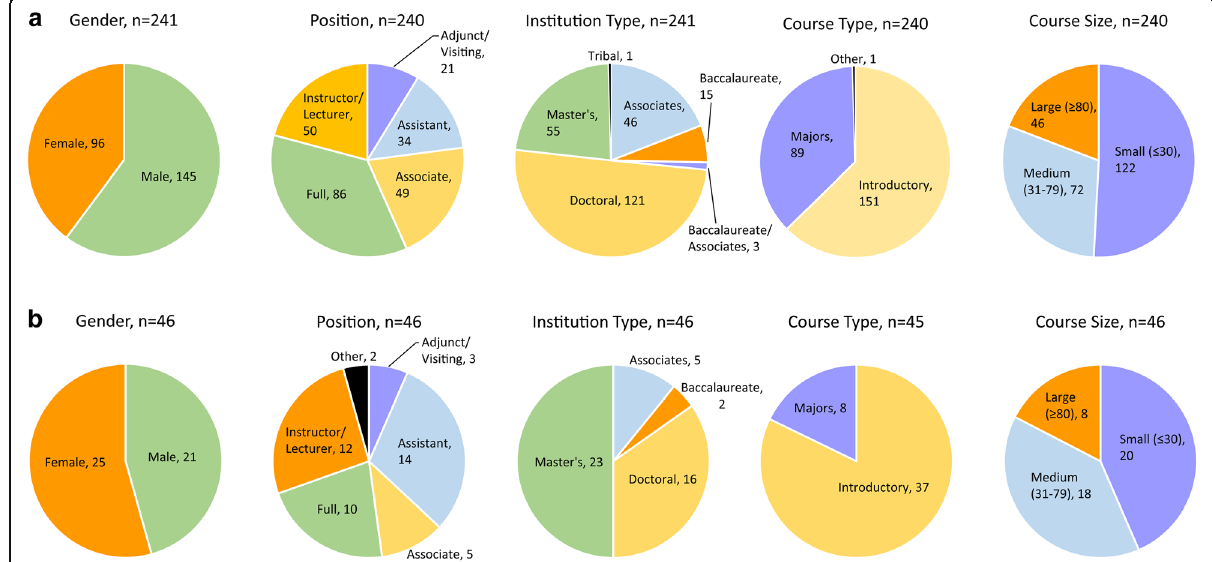
Fig. 10 Demographics of instructors who were only observed when they were not using ITG materials ( a ) and for instructors who were observed using ITG materials ( b ). Individual instructors are only shown in one